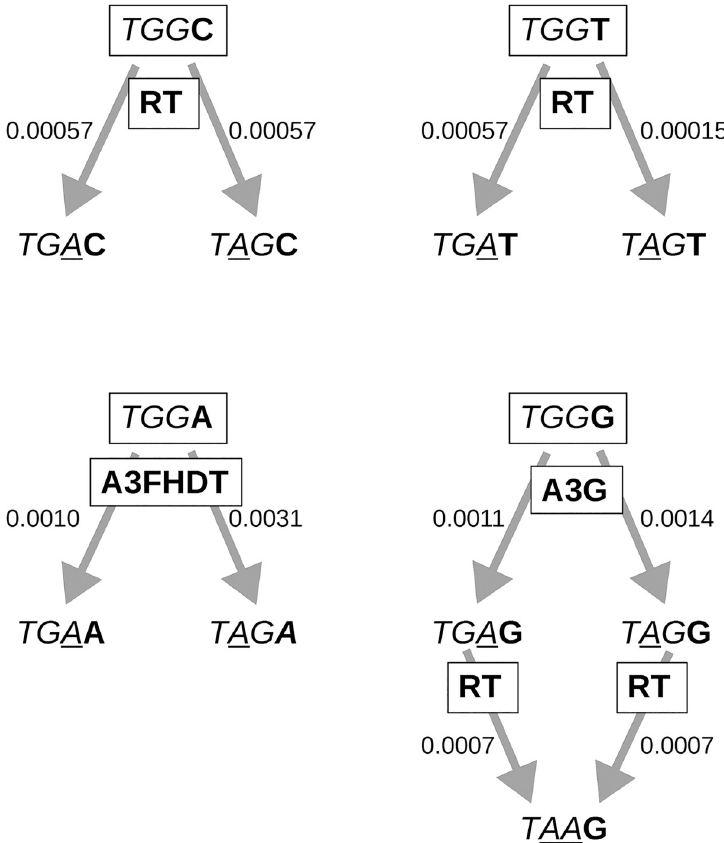
Fig 2. The context associated mutation rates of apobec3. The Context refers to cDNA sequences edited by members of apobec3 (A3) protein family. The human A3G protein targets the CC sequences on minus-strand cDNA, thus causing GG to AG mutations in the positive strand of HIV. A3G mutates TGG codons mainly to TAG stop codon when the TGG codon is followed by a G (TGGG). A3F/H/D mutate TGG to stop codons when TGG is followed by an A (TGGA). Reverse transcriptase has no preferences and can change TGG into any codon, including stop codons. Arrows indicate a mutation from TGG to a certain stop codon and numbers are the estimated mutation rates of stop codons. Boxes close to the arrows indicate the enzyme likely associate with a mutation indicated by the arrow. RT = reverse transcriptase. TGG = Tryptophan, TGA, TAA, TGA = Stop codons.